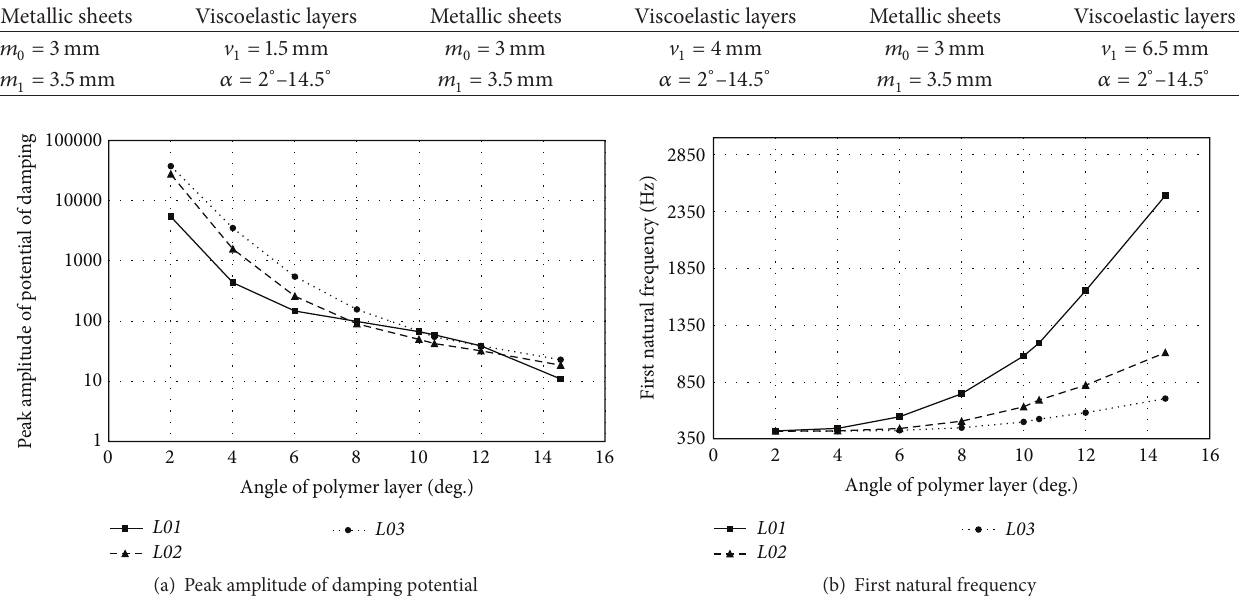
Figure 7: Influence of the angle of the viscoelastic layer on the L01 , L02, and L03 monolayer damper designs.